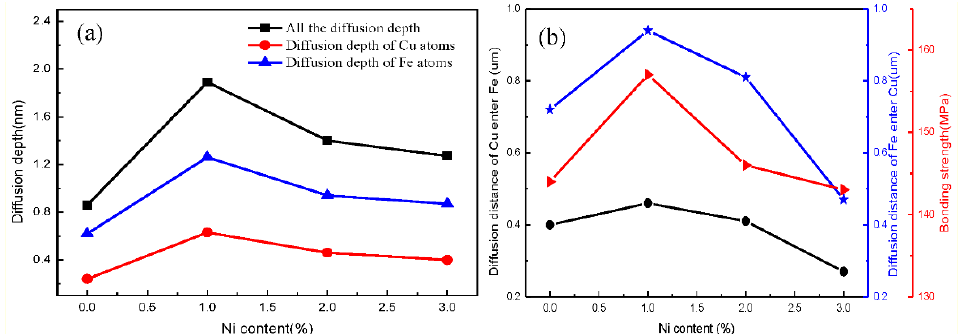
Figure 10. Diffusion and bonding characteristics with different nickel contents: ( a ) simulation results; ( b ) experimental results.